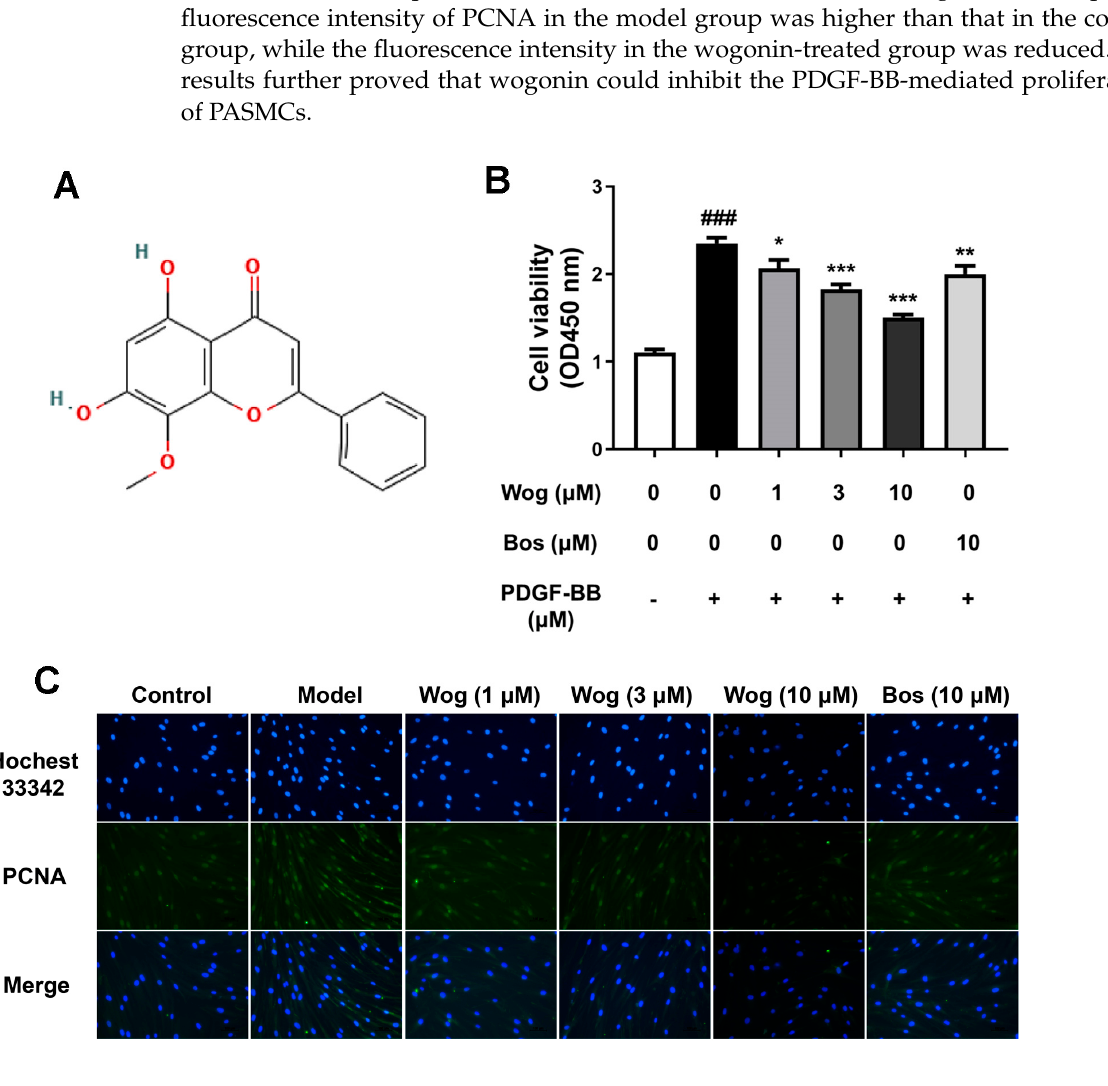
Figure 6. Wogonin inhibits PDGF-BB-mediated proliferation of PASMCs. PASMCs were cultured without or with PDGF-BB (40 ng/mL), PDGF-BB + wogonin (1, 3, 10 µ M), PDGF-BB + bosentan (10 µ M). ( A ) Chemical structure of wogonin. ( B ) Wogonin dose-dependently (1, 3, 10 µ M) inhibits PDGF-BB-mediated PASMCs cell viability. ( C ) Effect of wogonin on PCNA expression of PDGF-BB-mediated PASMCs (original magnification × 200). Results are presented as mean ± SEM (n = 6). ### p < 0.001 vs. control group, * p < 0.05, ** p < 0.01, *** p < 0.001 vs. model group.